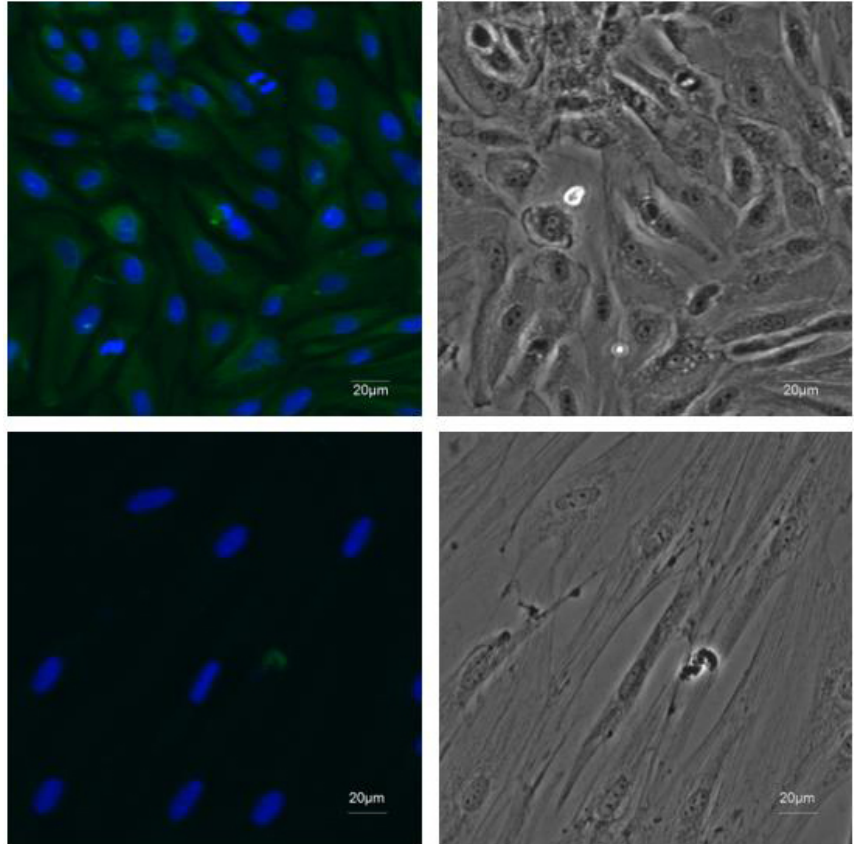
Figure 2. Identification of EECs. × 20 immunofluorescence was performed using antibodies recognizing CK18 (green) and DAPI to mark nuclei (blue) in the first-passage EECs. Fibroblasts were stained as negative